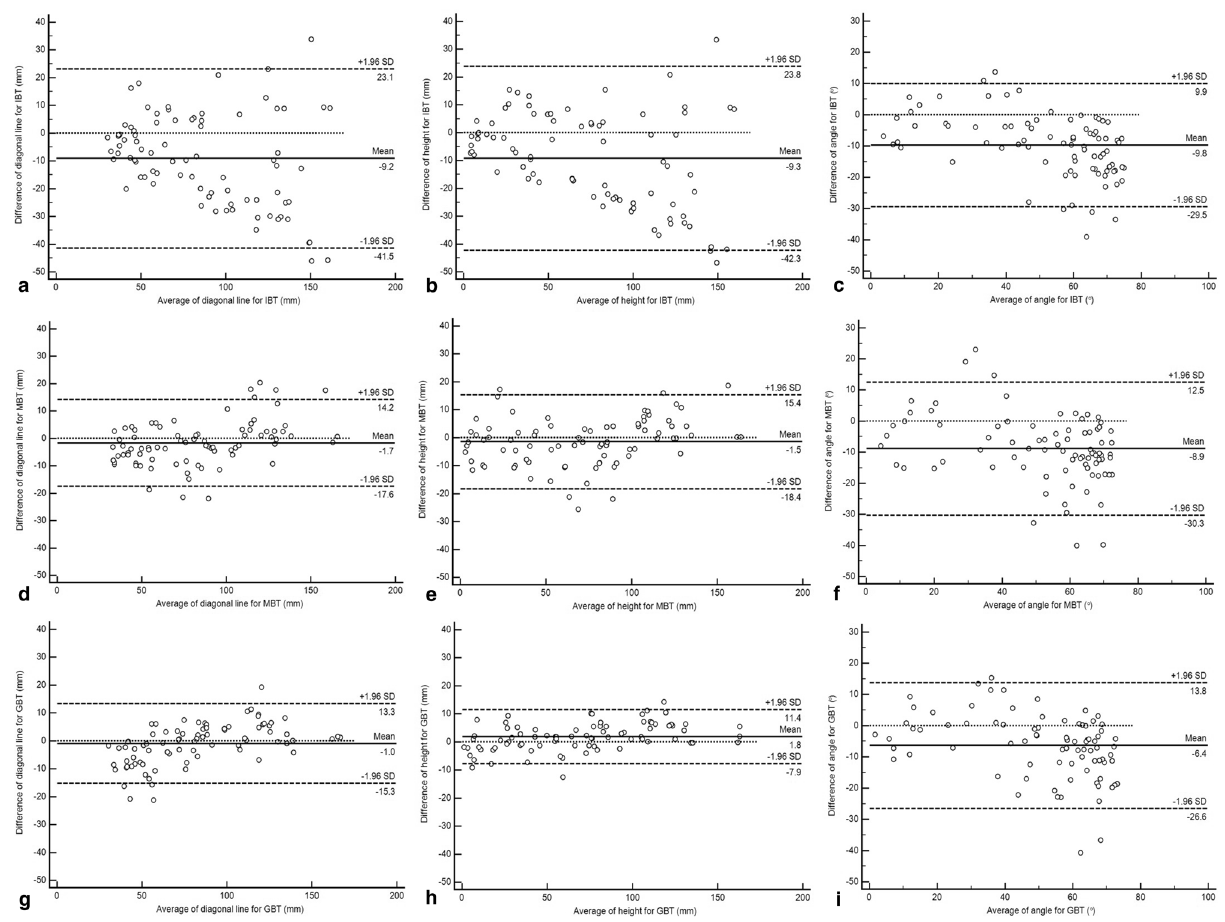
Figure 5. Bland–Altman plot indicating the distribution of the differences between DGM and IBT, divided by ( a ) diagonal line, ( b ) height and ( c ) angle; between the DGM and MBT, divided by ( d ) diagonal line, ( e ) height, ( f ) angle; and between the DGM and GBT, divided by ( g ) diagonal line, ( h ) height, and ( i ) angle.